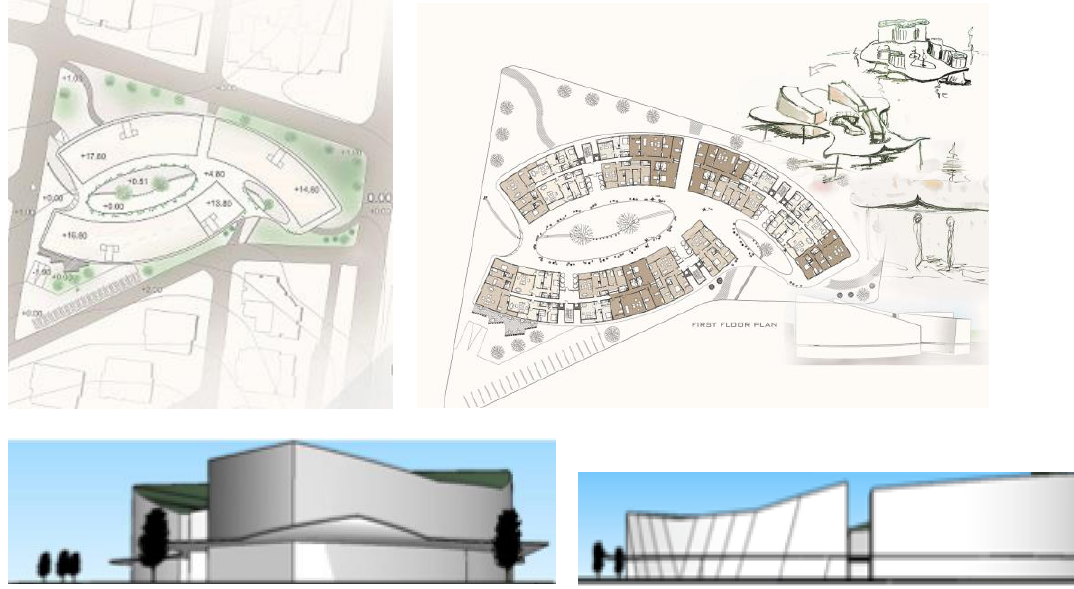
Figure 2. Büşra Beşen - Public Space for Youth